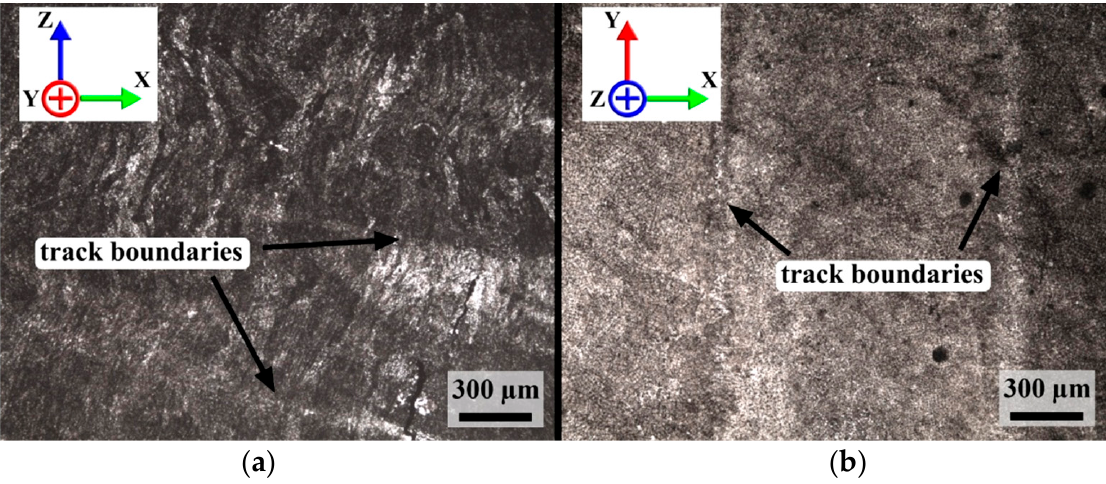
Figure 11. Macrostructure of the original sample after annealing (HT1), where ( a ) is the perpendicular direction ( Y ) and ( b ) is the longitudinal direction ( X ). All of the types of obtained microstructures after heat treatment are shown in the diagram at ×500 magnification (Figure 12).